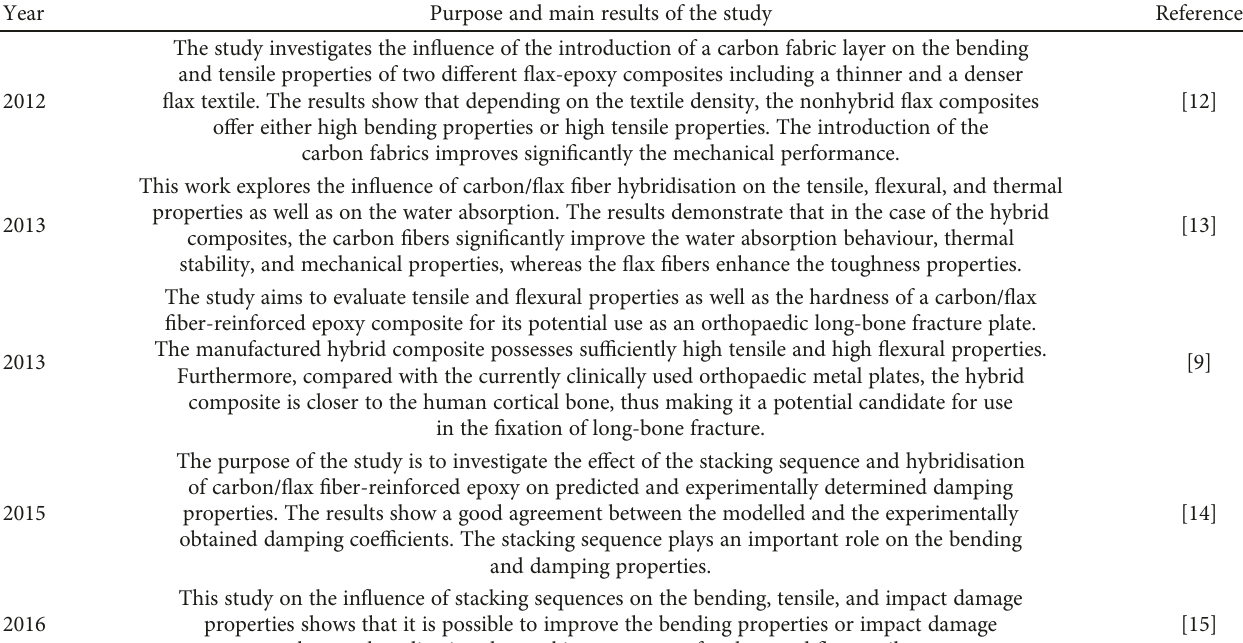
Table 1: Overview of the studies on carbon-/ fl ax polymer